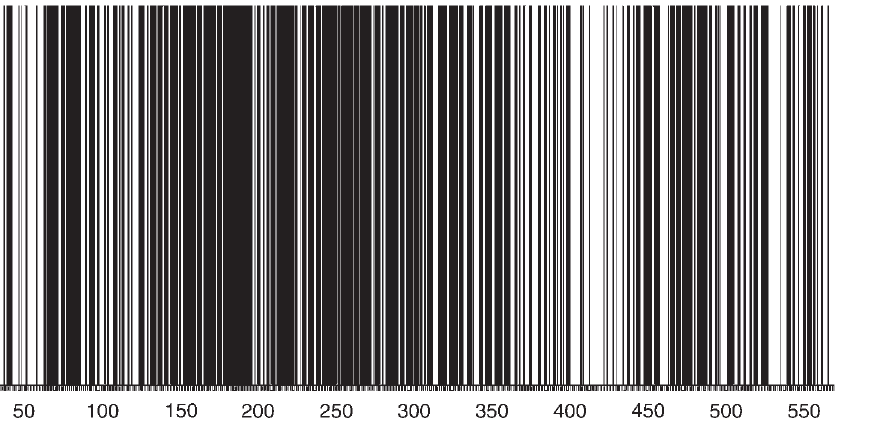
Figure 3. Physical Map of